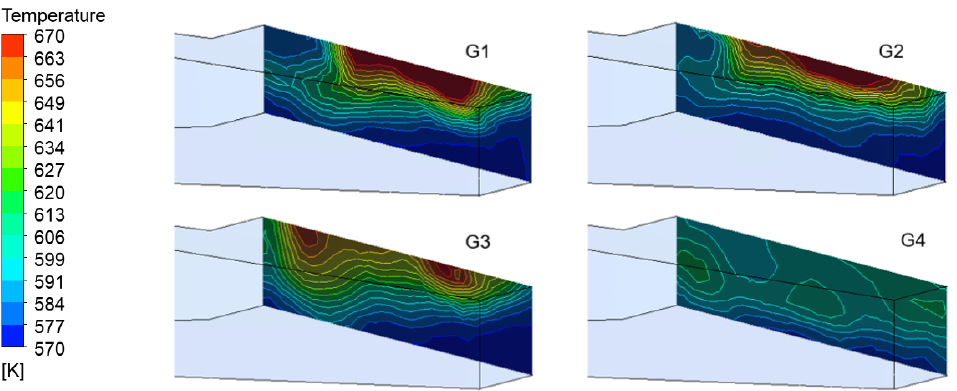
Figure 7. The temperature distributions at the computational domain outlet for each geometric var- iant.